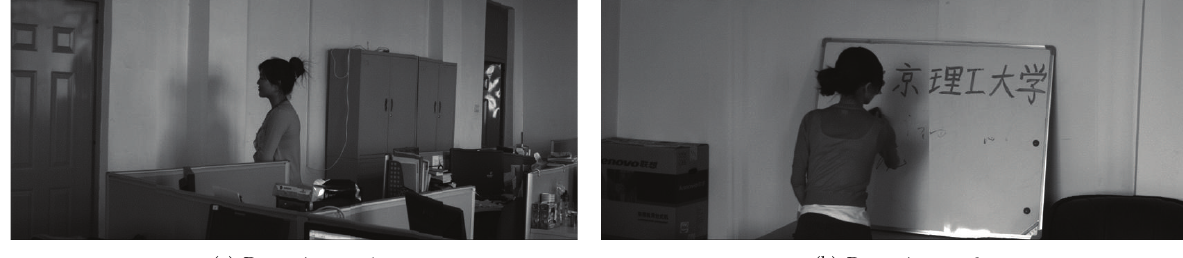
Figure 9: Stitching results of the proposed method.